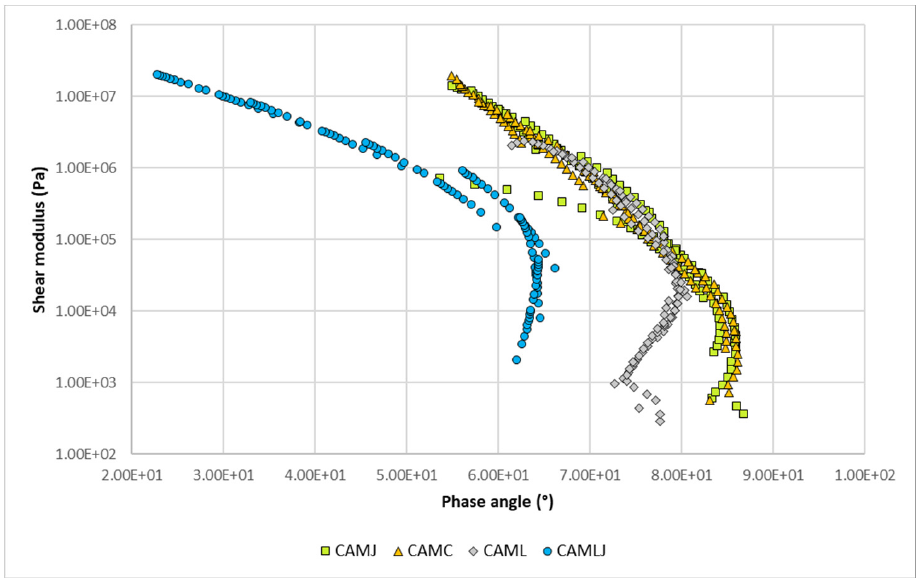
Figure 10. Black diagram comparing the cold asphalt mastics.